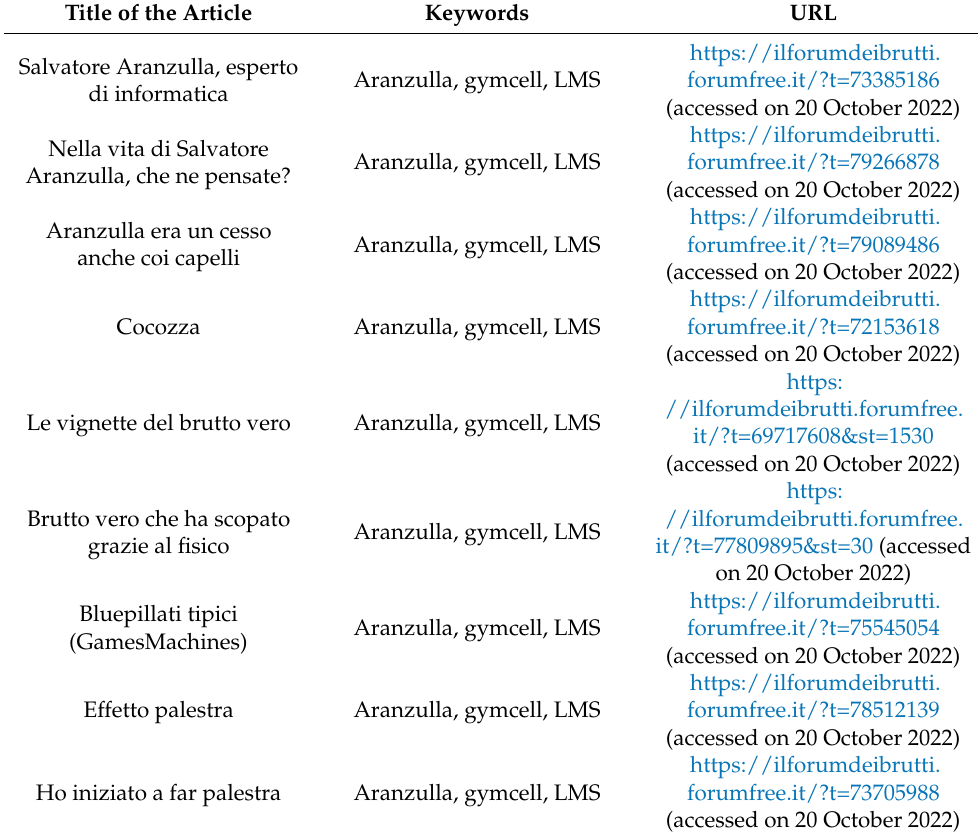
Table 2. List of consulted discussion threads on the Forum degli Incels and Forum dei Brutti